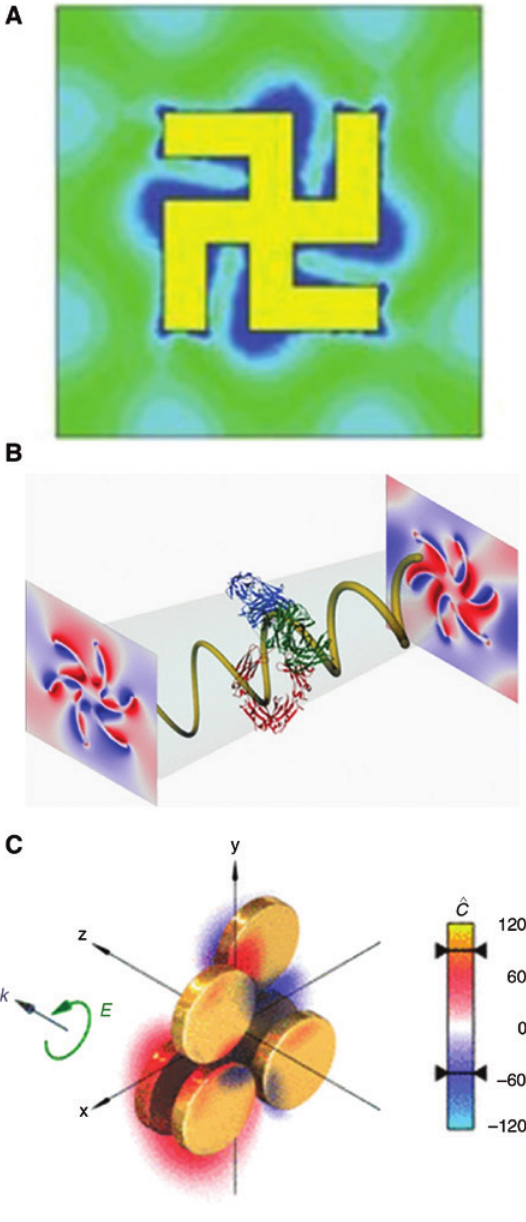
Figure 3: Optical chirality enhancements in the vicinity of various chiral metamaterials and nanostructures: (A) the